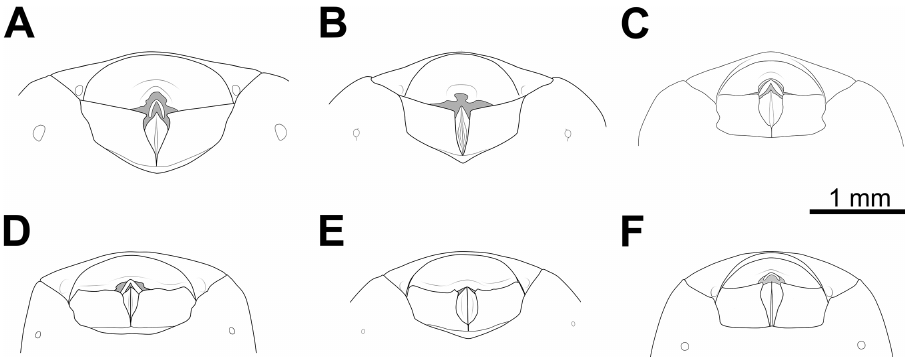
Figure 5. Female external genitalia of six morphospecies in ventral view A type fA, Biasticus taynguyenen- sis Ha, Truong & Ishikawa, sp. nov., holotype, ♀ , HNL2018-073 B type fB, B. griseocapillus Ha, Truong & Ishikawa, sp. nov., holotype, ♀ , HNL2018-038 C type fC, B. luteicollis Ha, Truong & Ishikawa, sp. nov., paratype, ♀ , HNL2018-024 D type fD, B. flavinotus (Matsumura, 1913), ♀ , HNL2018-117 E type fE, B. confusus Hsiao et al., 1979, ♀ , VN-Hem-1998-012 F type fF, B. flavus (Distant, 1903), ♀ , LA-